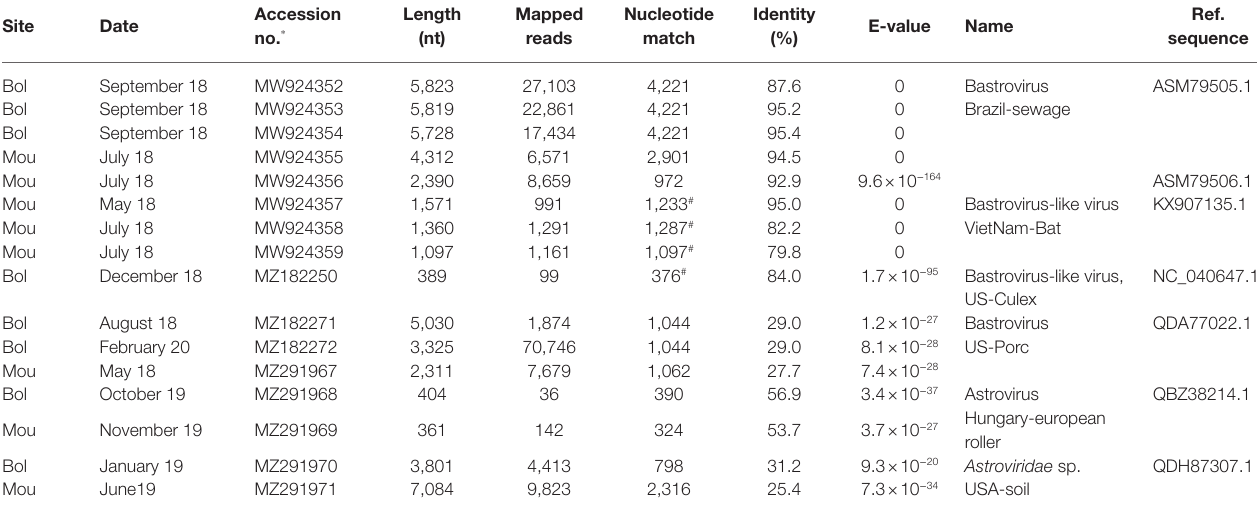
TABLE 3 | Astroviridae contigs identified in Sanaga